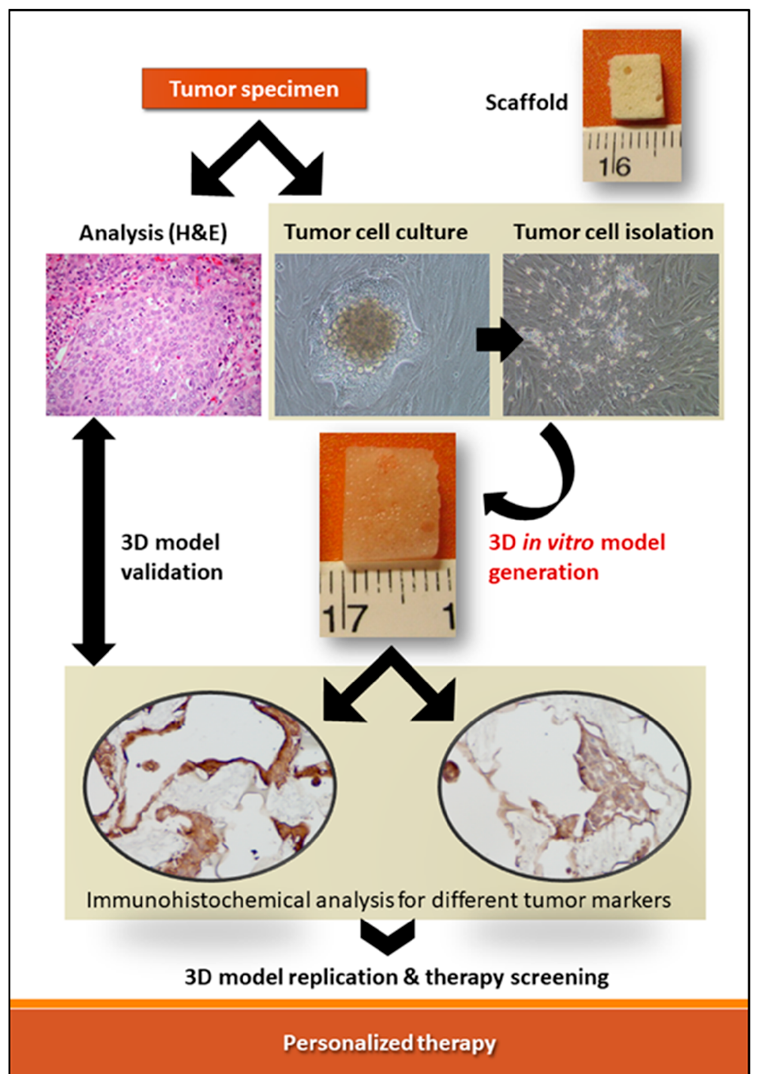
Figure 1. Schematic depicting the combined application of patient’s larynx tumor-derived cells (TCCR3) and polyvinyl alcohol (PVA) spongy scaffold to create 3D in vitro tumor models. Immuno- histochemical analysis shows immunopositivity (in brown) for Integrin α 5 (on the left) and Smad4 (on the right). All figures in the schematic are original unpublished material of the authors.